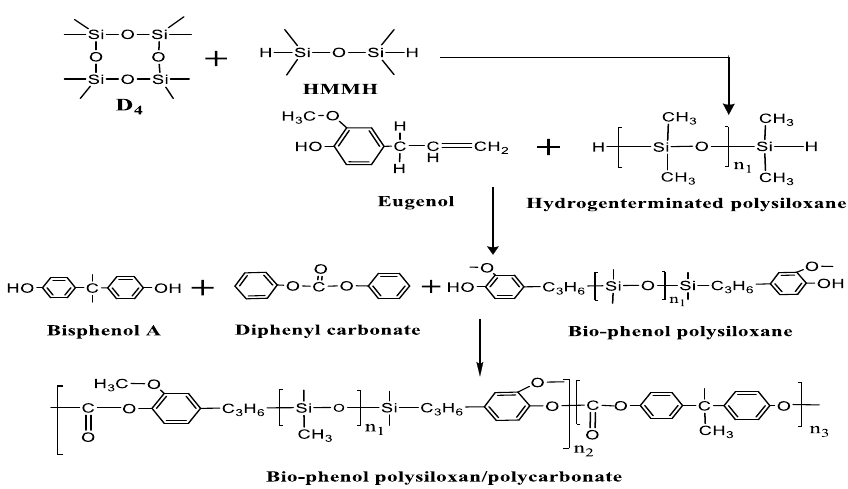
Figure 1. The synthetic equation of bio-phenol polysiloxane/polycarbonate block copolymer.